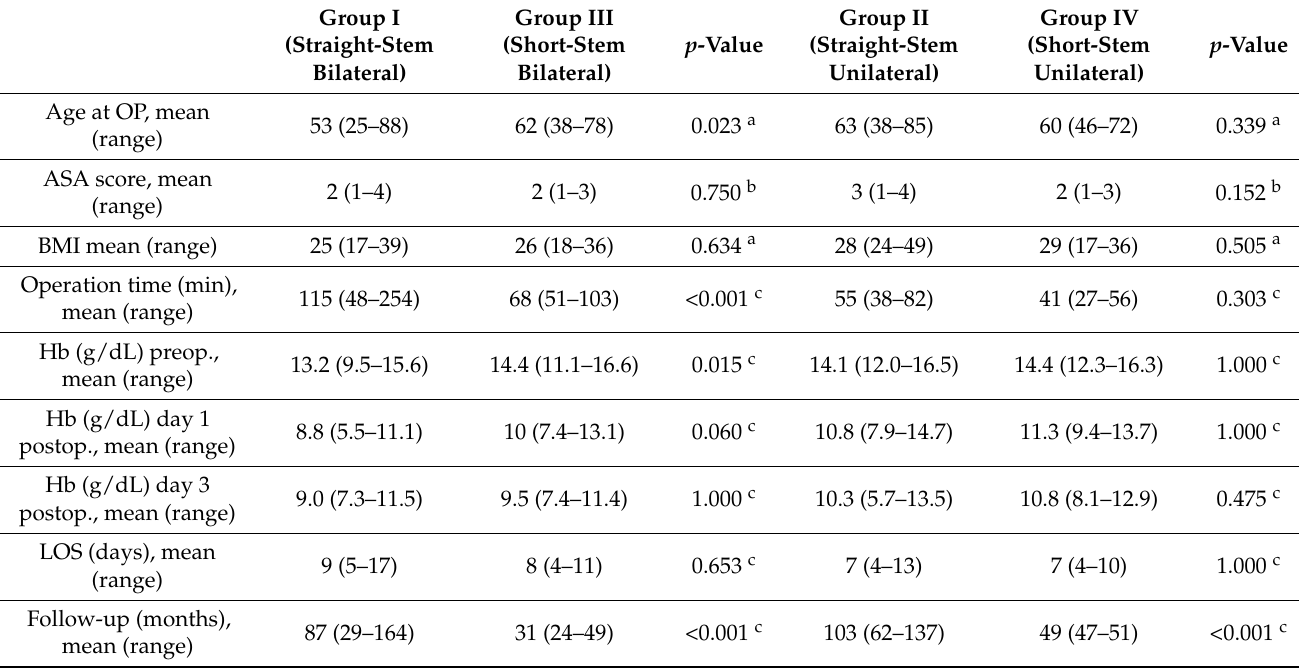
Table 1. Demographic and clinical